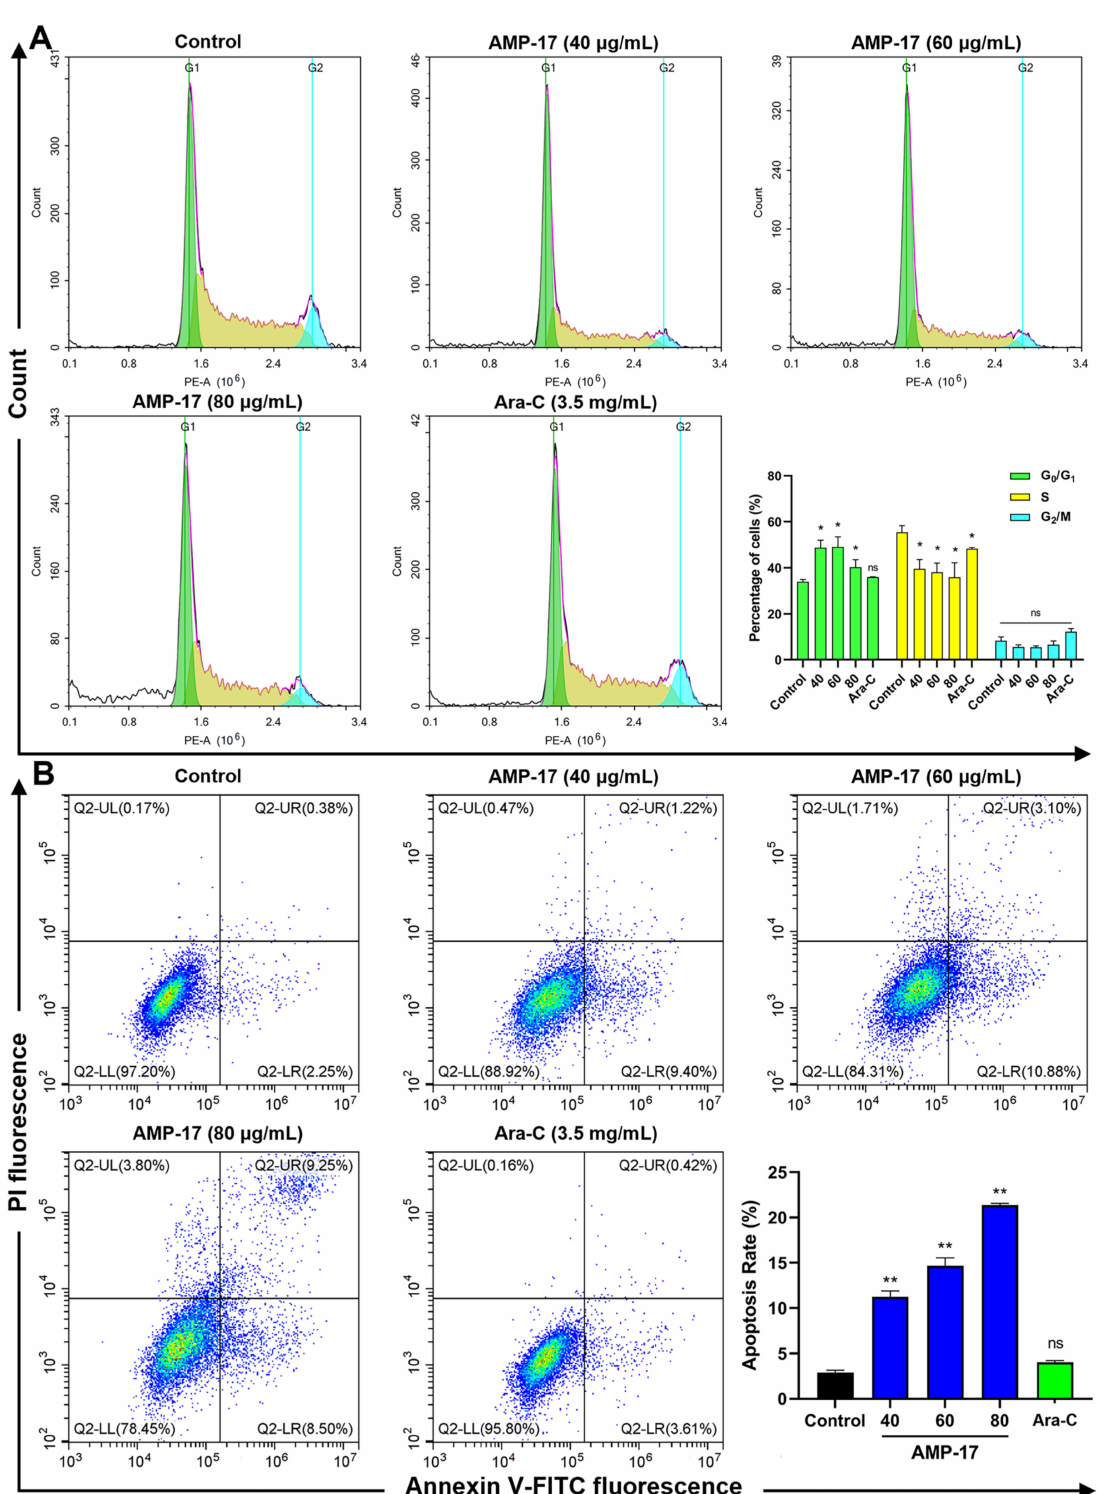
Figure 4. AMP-17 induced apoptosis and cell cycle arrest in K562. ( A ) Cell cycle distribution of AMP-17-treated K562 cells for 24 h was analyzed by flow cytometry. Ara-C was used as a drug control. Data are presented as the mean ± SD of twice independent experiments (* p < 0.05). ( B ) Apoptosis rate of K562 cells treated with AMP-17. K562 cells were treated with AMP-17 and Ara-C for 24 h and then determined by Annexin V-FITC/PI assay. Data are presented as the mean ± SD (** p < 0.01). The experiment was repeated three